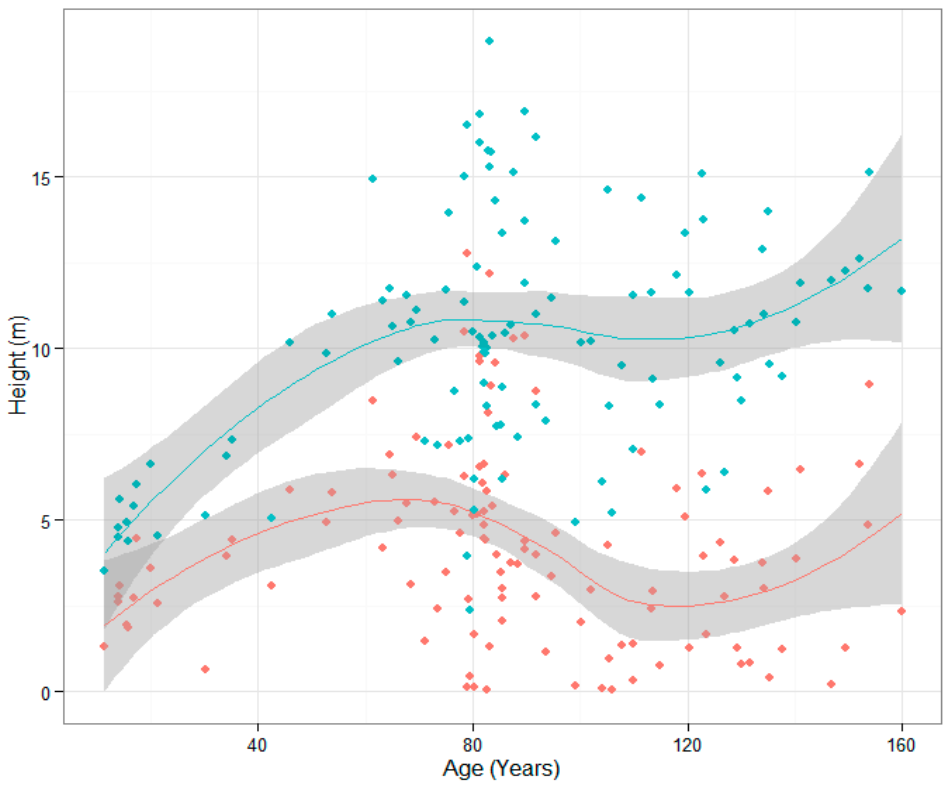
Figure 4. Scatter plot of ALS fifth (P50) in orange and ninth (P90) in turquoise decile height (metres) at plot ages (years) shaded grey is 95% confidence interval. LOESS curves are fit to the distributions.